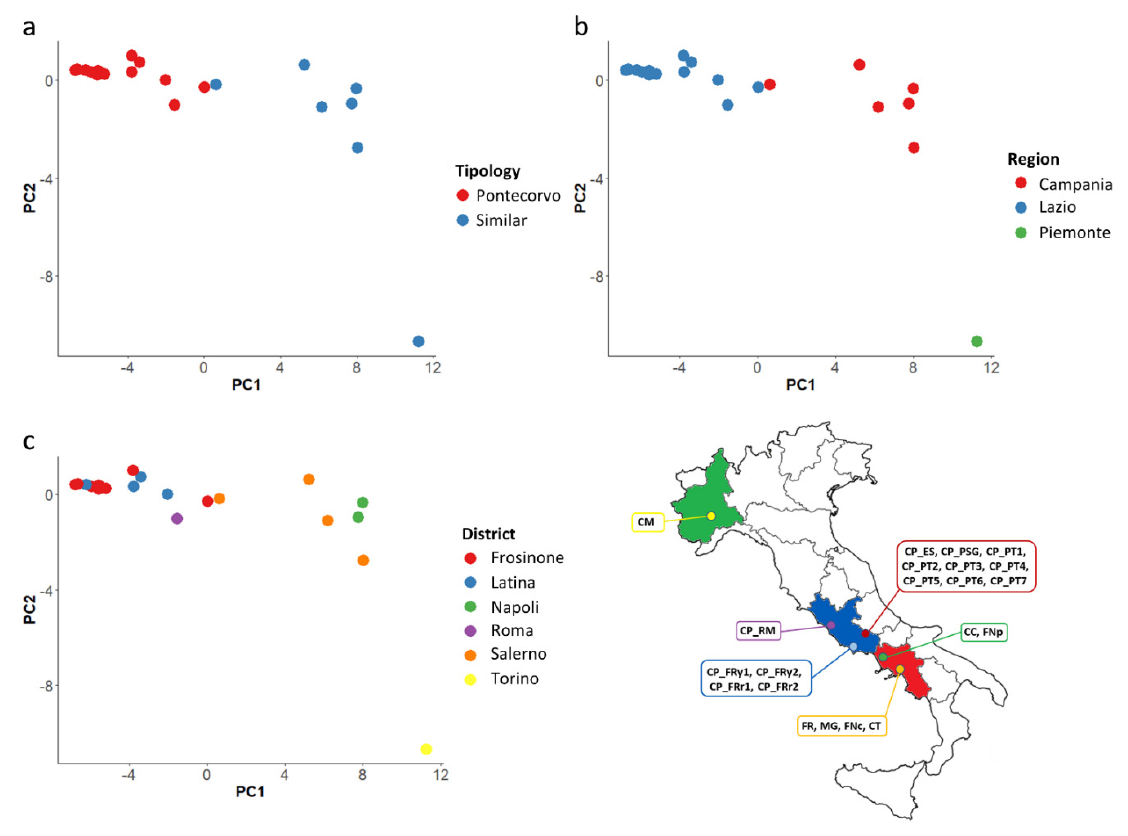
Figure 7. Loading plot in the first two components, showing the genomic diversity of 21 studied pepper accessions. ( a ) PCA displaying the differences between ‘Peperone Cornetto di Pontecorvo’ accessions and similar types. ( b ) Differences based on the region of provenance. ( c ) Stratification of the collection on the basis of the area of provenance (district) with additional details on the map. Description and acronyms for each accession are in Table 1.